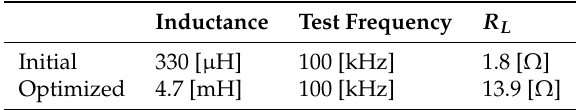
Table 5. Inductor values comparative through [32] datasheet.